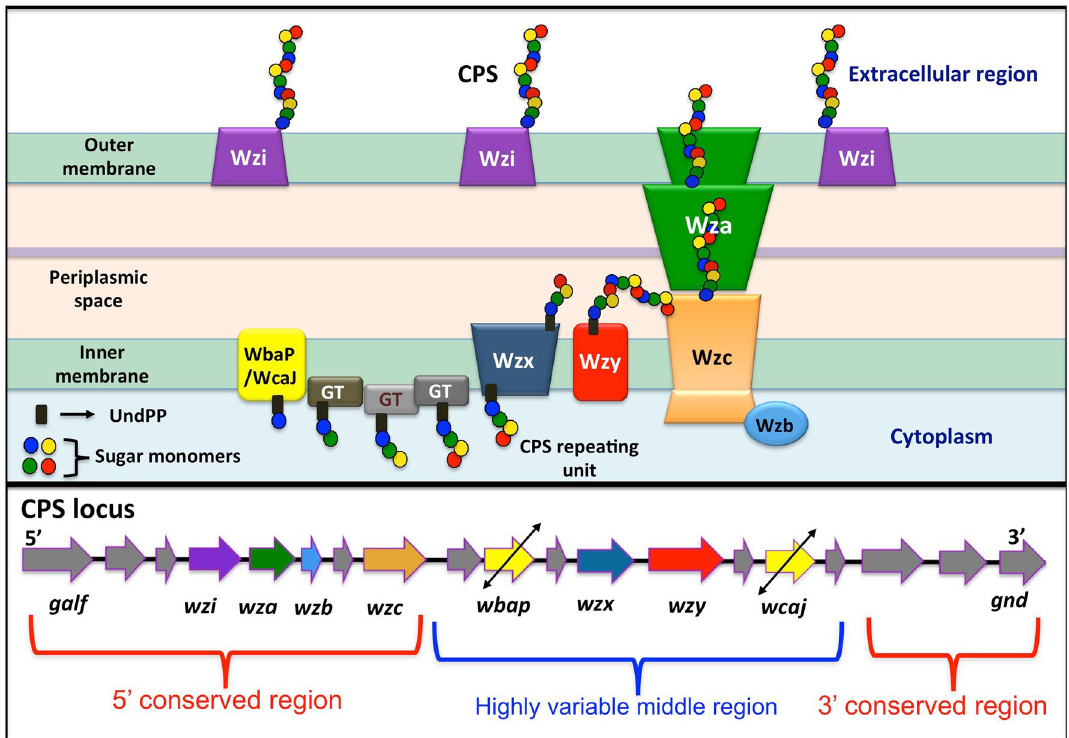
Figure 1. Schematic illustration of (top) the Wzx/Wzy dependent pathway involved in the Klebsiella spp CPS transportation and surface expression, and (bottom) the representative cps locus